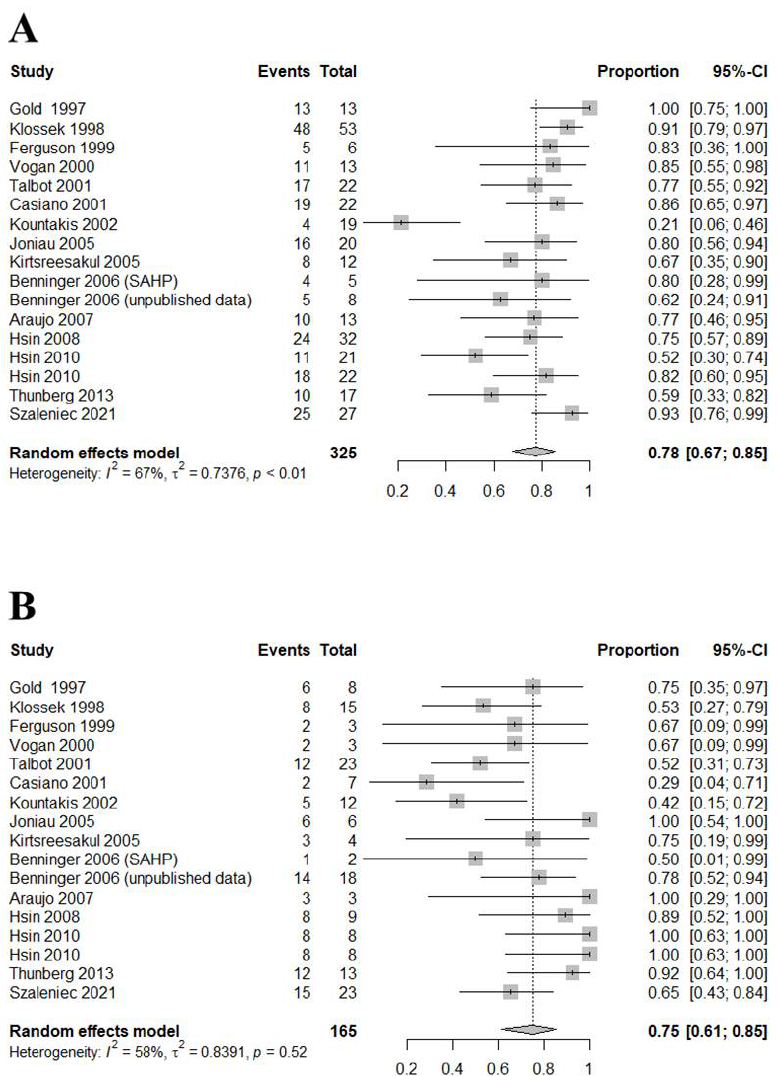
Figure 5. Forest plots of the sensitivities ( A ) and specificities ( B ) of all studies